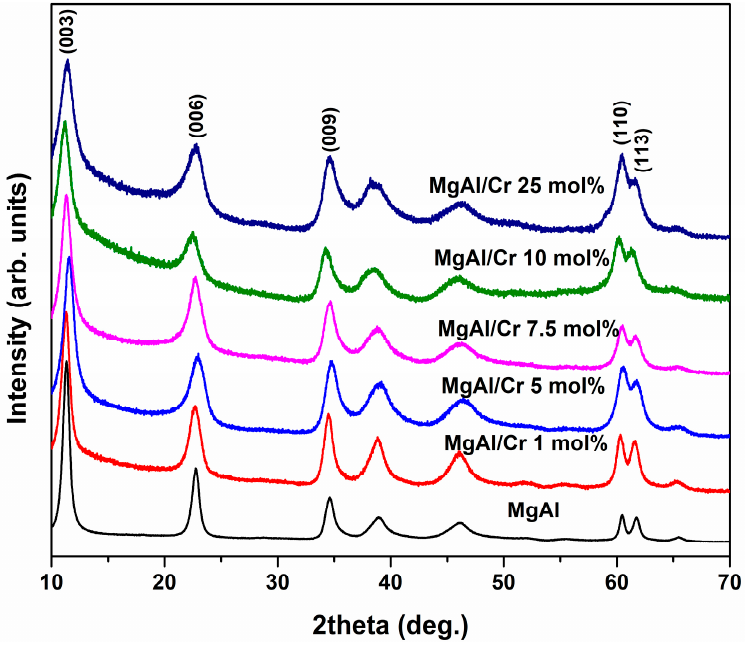
Figure 1. X-ray diffraction (XRD) patterns of Cr-substituted Mg 3 Al 1-x Cr x LDHs.